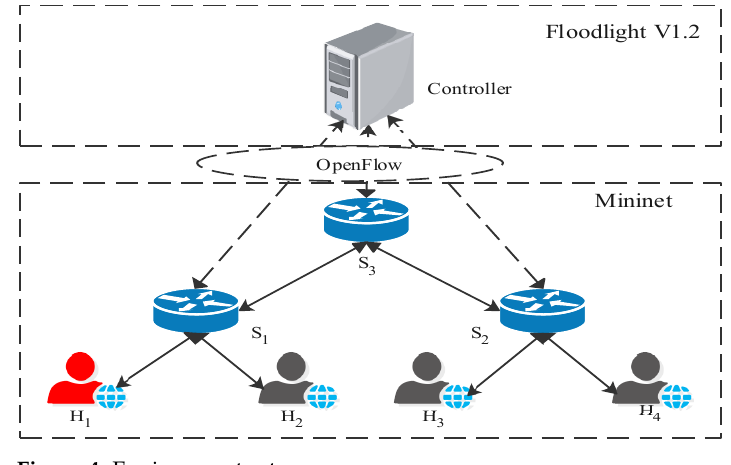
Figure 4. Environment